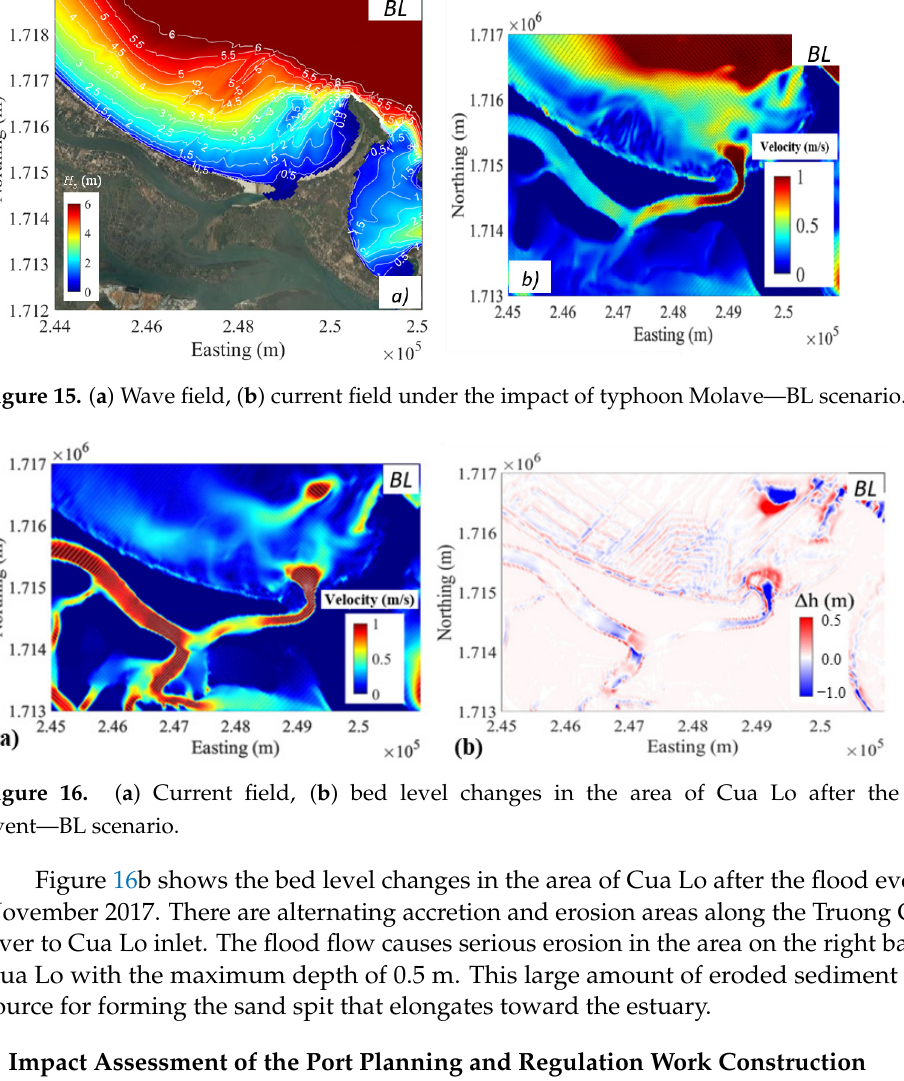
Figure 16. ( a ) Current field, ( b ) bed level changes in the area of Cua Lo after the flood event—BL scenario.